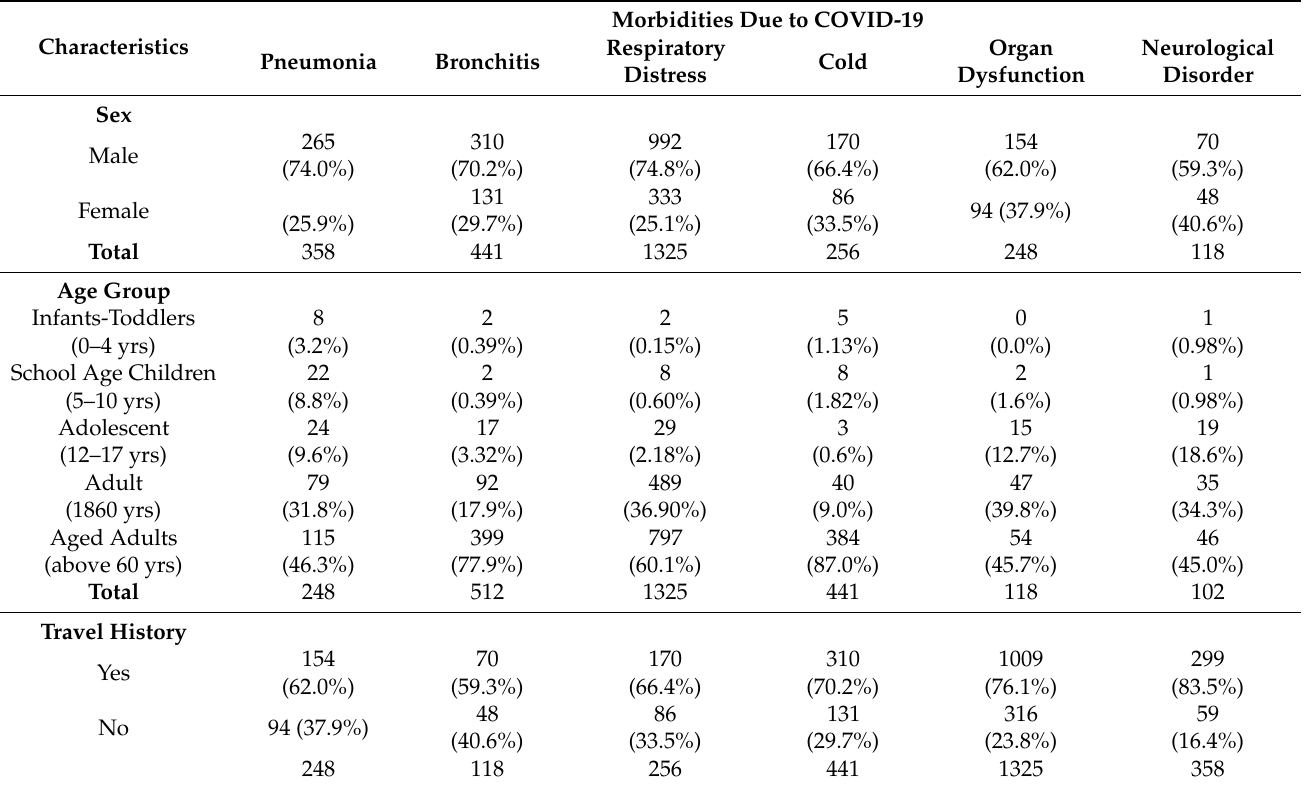
Table 6. Socio demographic Characteristics against Morbidity Due to COVID-19 in